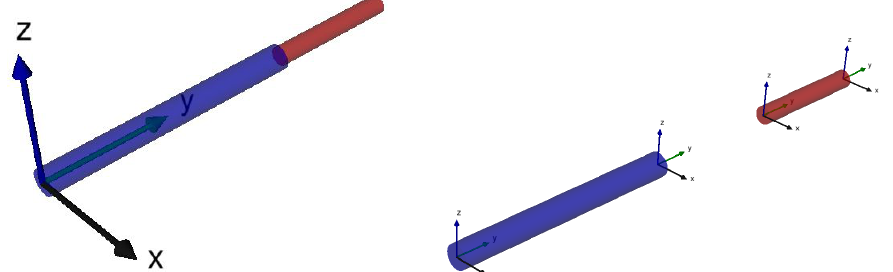
Figure 10. A two-stage rocket (stage 1: blue cylinder, stage 2: red cylinder). ( Left ): At initialization. ( Right ): After separating (release). The locking mechanisms at the top and bottom are each visualized with a coordinate